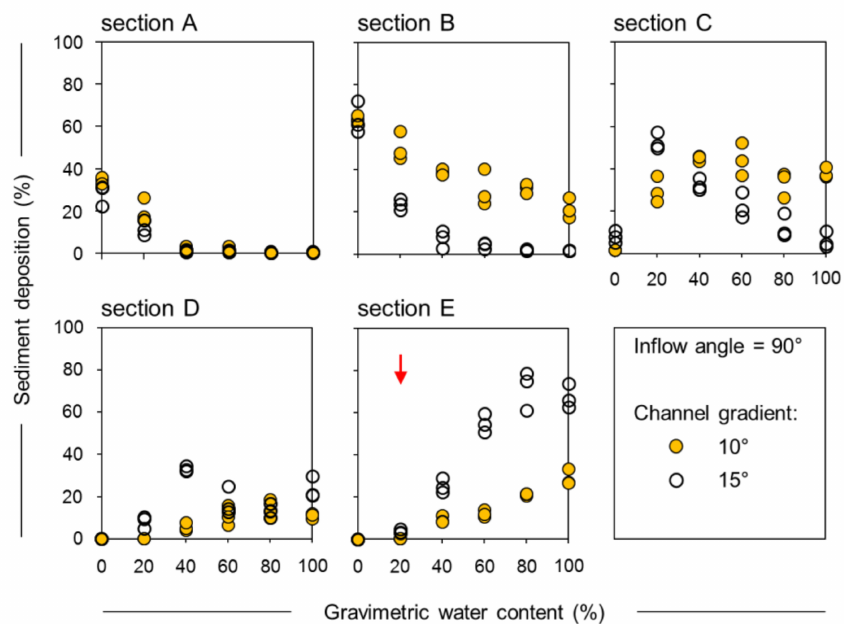
Figure 4. Sediment deposition in response to channel gradient modification for the 90 ◦ inflow angle, using sand and shale sediment. The arrow represents saturated water content of sand and shale